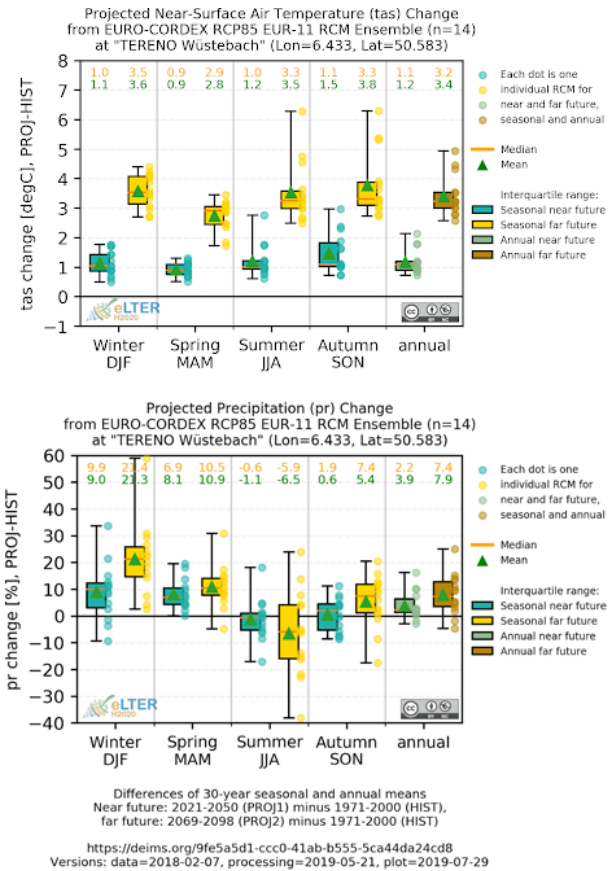
Figure 3. Example eLTER EURO-CORDEX climate scenario data visualisation for one of the TERENO sites in western Germany: (a) near-surface air temperature (tas) and (b) total precipitation